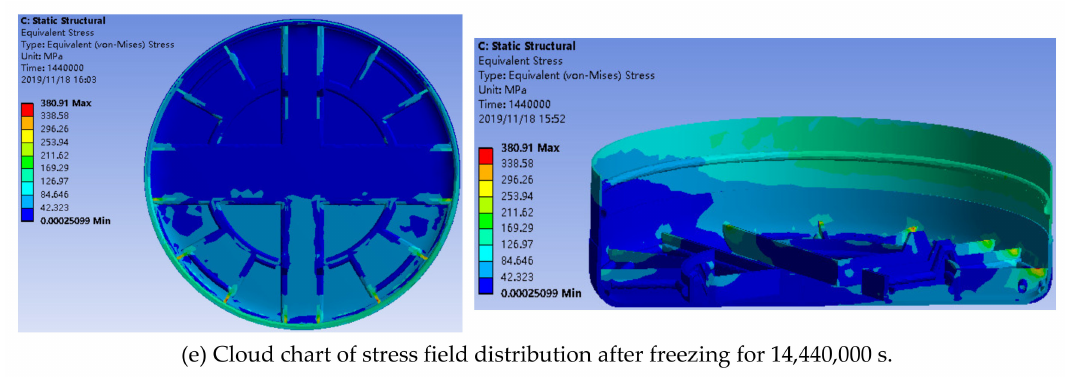
Figure 6. Stress field contours of the cutter head.